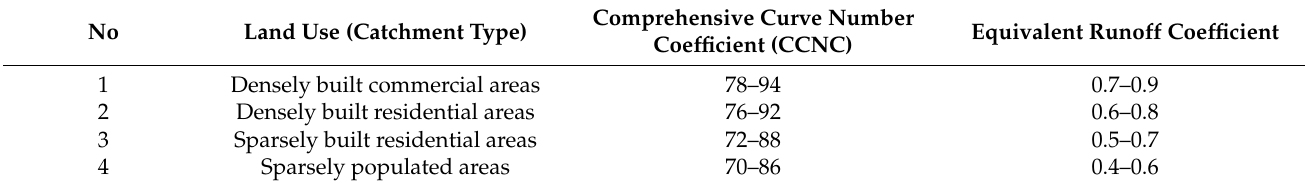
Table 3. Empirical values of the regional comprehensive curve number